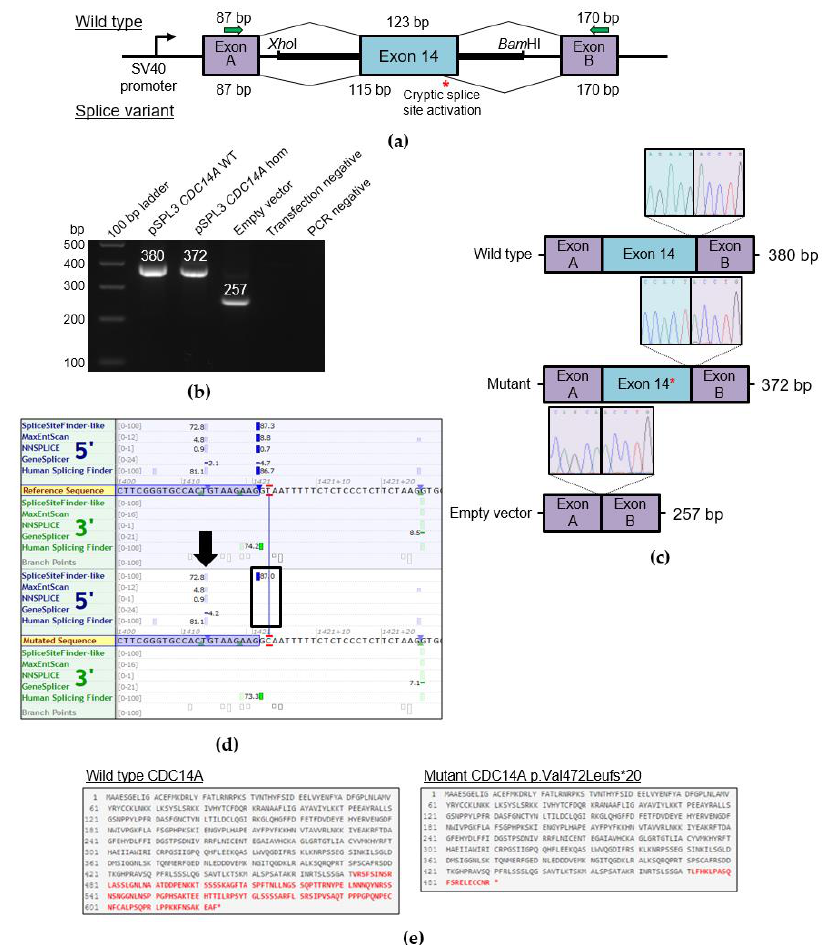
Figure 2. Characterization of the CDC14A c.1421 + 2T > C exchange via a minigene assay. ( a ) A schematic of the pSPL3 exon trapping vector with cloned CDC14A exon 14 (blue) and flanking sequence containing Xho I and Bam HI restriction sites that was directly amplified from proband and wild type genomic DNA. Exons A and B (purple) originate from the vector. A schematic of the resulting splice products is shown, with the wild type splicing profile (top) and splice variant sequence that activates a cryptic splice site (bottom, red asterisk). The PCR primers that were used to amplify the Exon A splice donor region (SD6) and Exon B splice acceptor region (SA2) are depicted by green arrows. ( b ) Electrophoretic visualization of cDNA RT-PCR products amplified from constructs after transfection into HEK293T cells. Amplicons were resolved on a 1% agarose gel. Wild type splicing (lane: pSPL3 CDC14A WT) yields a 380 bp product that constitutes the Exon A, exon 14 and Exon B amplified regions. The homozygous mutant amplicon (lane: pSPL3 CDC14A hom) shows a band around 380 bp that, when sequenced, indicates a cryptic splice site activation. The empty vector shows the expected 257 bp product. ( c ) Sequencing electropherograms of the exon 14 5 (cid:48) splice site boundaries for the RT-PCR products for wild type (top), mutant showing cryptic splice site activation (middle) and empty vector (bottom). ( d ) In silico splice prediction tools for the c.1421 + 2T > C exchange that is marked with red lines visualized with Alamut visual (2.10). The upper panel shows the reference sequence splice scores and the lower panel shows the splice scores for the c.1421 + 2T > C exchange with multiple in silico prediction tools estimating the loss of the native exon 14 5 (cid:48) donor splice site that is due to the variant (shown with a black box). In the mutant panel, the splice scores of an adjacent cryptic 5 (cid:48) donor site are either unchanged or strengthened and marked with a black arrow. ( e ) E ff ect of the splice variant on the protein, comparing wild type (top) and the truncated (bottom) protein resulting from the aberrantly spliced product (visualized with Mutalyzer). The amino acid residues marked in red are those that are altered due to the